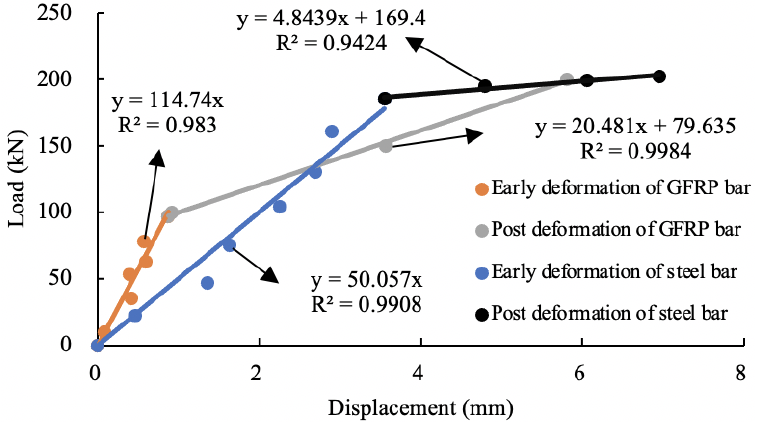
Figure 15. Load displacement curve of the bar excluding the bar body deformation of free section